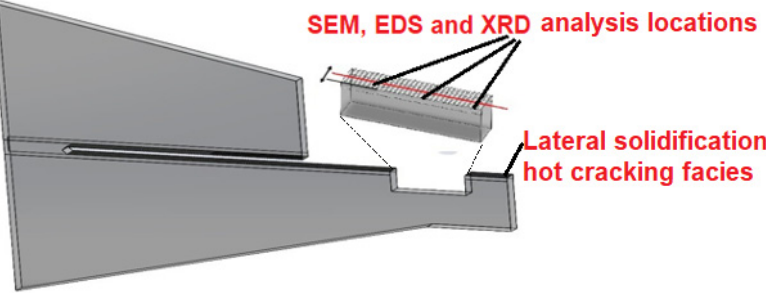
Figure 4. Microstructural characterization analysis